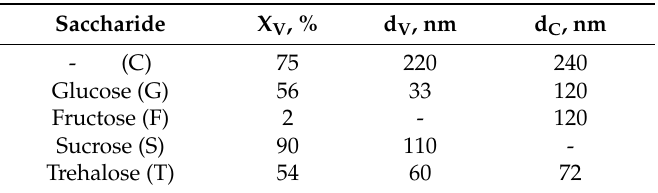
Table 2. Percentage content of vaterite and the mean size of calcite and vaterite crystallites in produced calcium carbonate